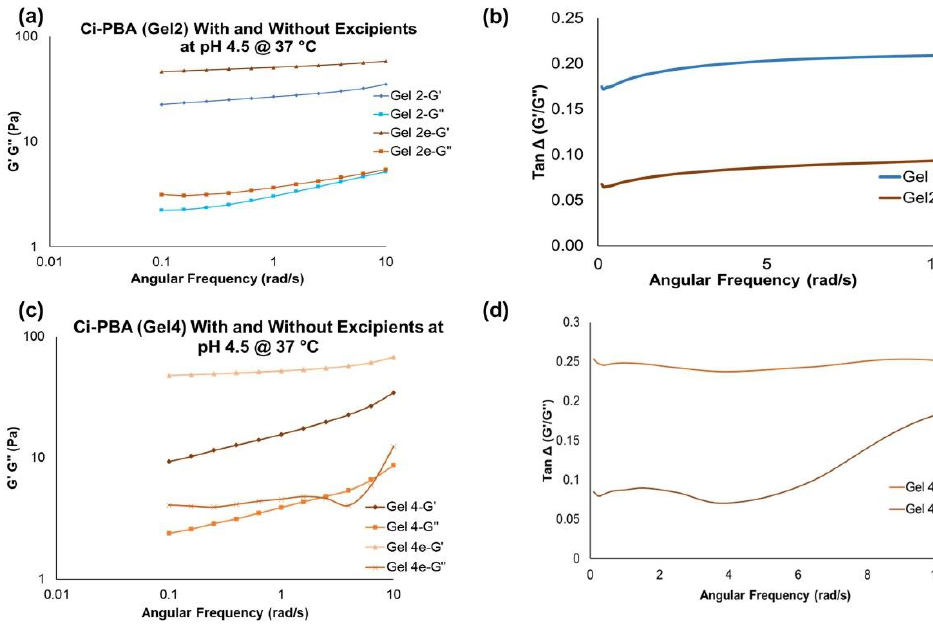
Figure 5. G′ and G″ overlay values and Tan Δ values for C i -PBA Gel 2 ( a , b ) and Gel 4 ( c , d ), respec- tively, (2e and 4e are gels with excipients). The values show that gels with excipients were relatively harder compared to the non-excipient formulations.